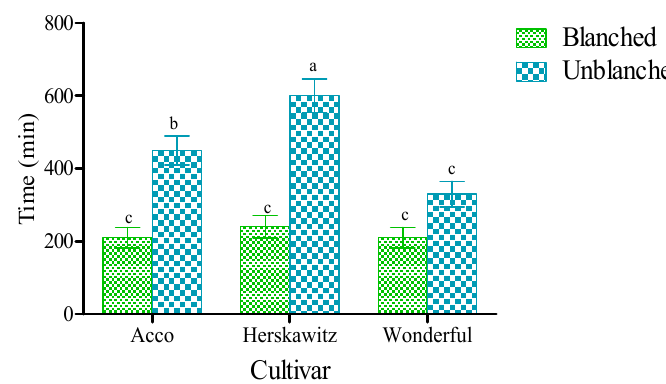
Figure 3. Drying time (min) of arils extracted from pomegranate cultivars (Acco, Herskawitz and